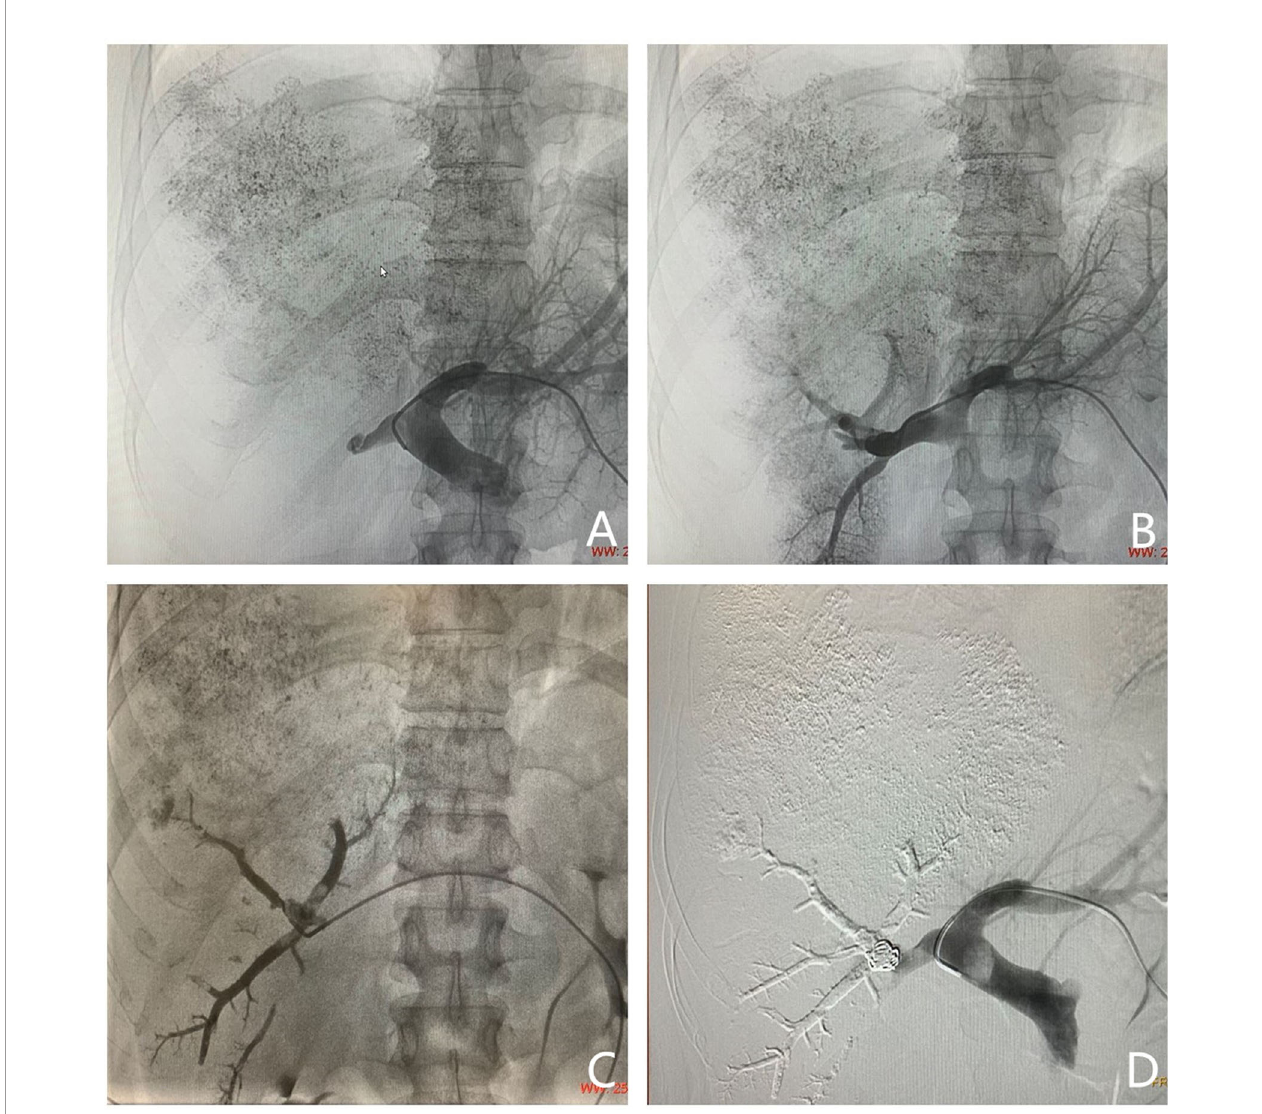
FIGURE 2 | Images of portal vein embolization performed in a 44-year-old man (same patient as in Figure 1 ). Puncturing a suitable branch of the portal vein with the guidance of ultrasound. (A) Portography with a catheter placed into the main portal vein. The right portal vein is not completely visible; it appears as a thrombosis in the right portal vein and matched the images acquired by magnetic resonance imaging. (B) Portography with a catheter placed into the right portal vein. (C) Image showing embolizing of the targeted portal vein. (D) Portography after embolizing of the right portal vein. The targeted portal vein was embolized using an NBCA/ Lipiodol mixture and